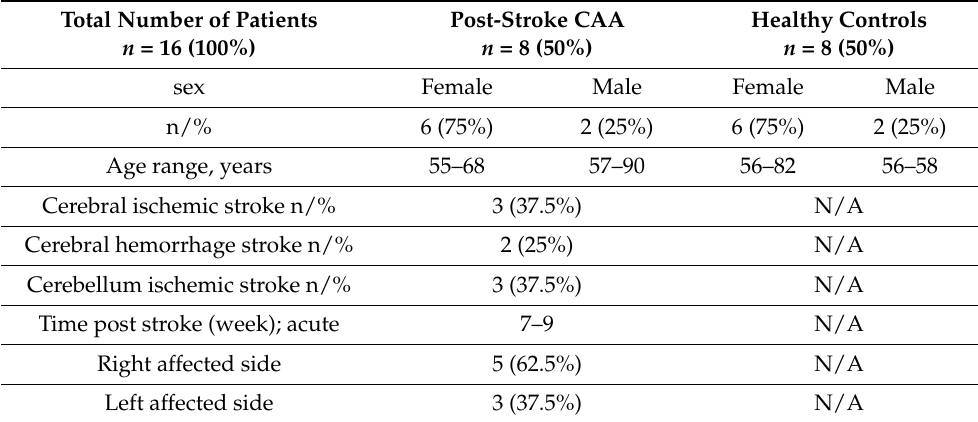
Table 1. The epidemiological data of post stroke (CAA) and healthy control groups.